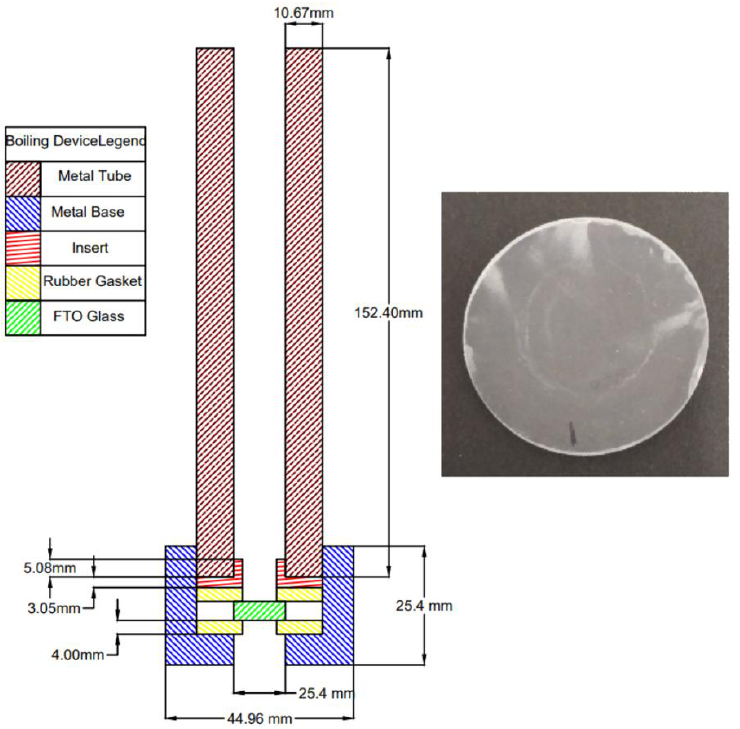
Figure 2. Section view of the nanoparticle-boiling deposition device and a typical image of FTO glass substrate after TiO 2 deposition.